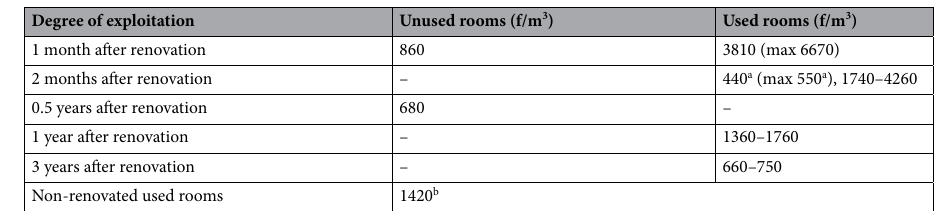
Table 1. The “BERLIN” building, incorrectly renovated without removing asbestos-containing products. The variability of asbestos fibres concentration with time (average values). a Intensive ventilation of rooms between the repair and the beginning of tests. b Active sources of dust contamination present in the rooms, large ACM